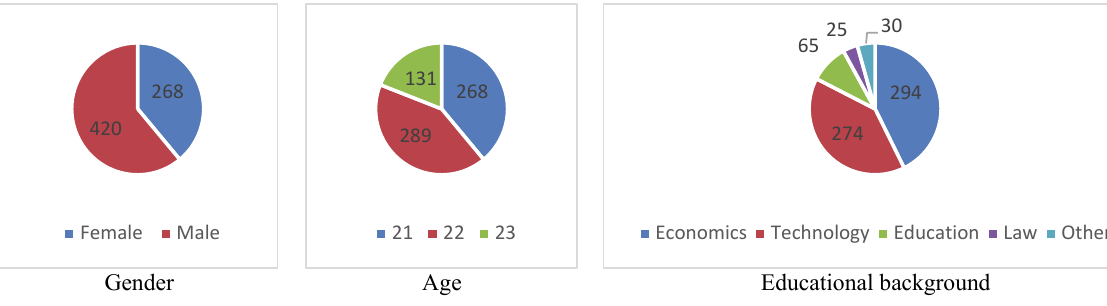
Fig. 1. Personal characteristics of the